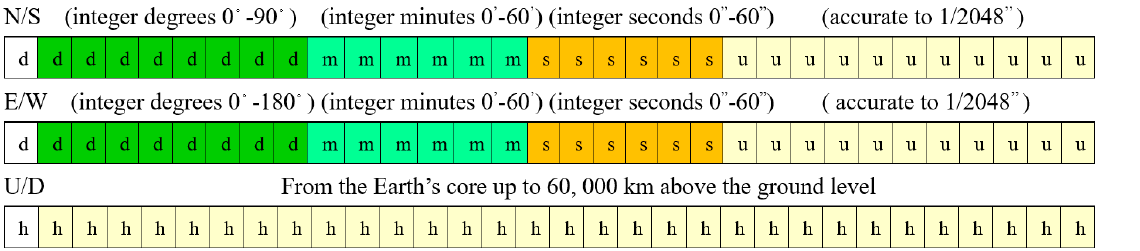
Figure 7. Geographical interpretation of GeoSOT binary three-dimensional (3D) code.